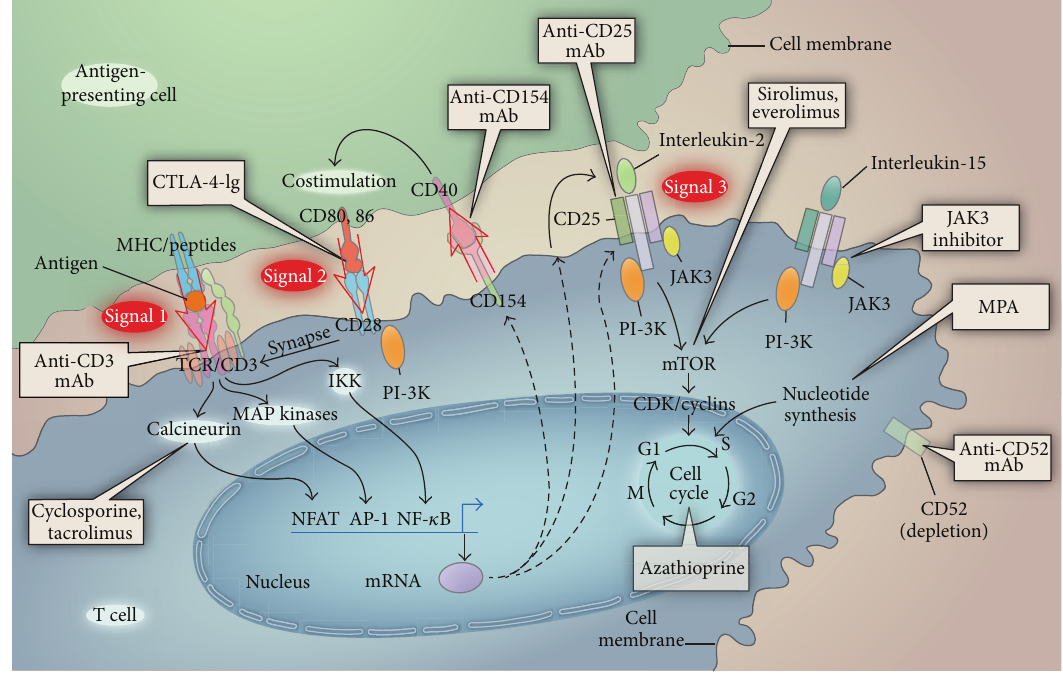
Figure 1: Sites of action of immunosuppressive drugs (adapted from [33] with